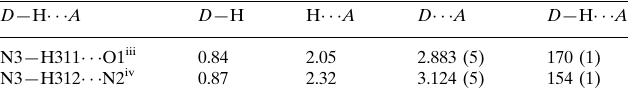
Hydrogen-bond geometry (A˚ , (cid:3)